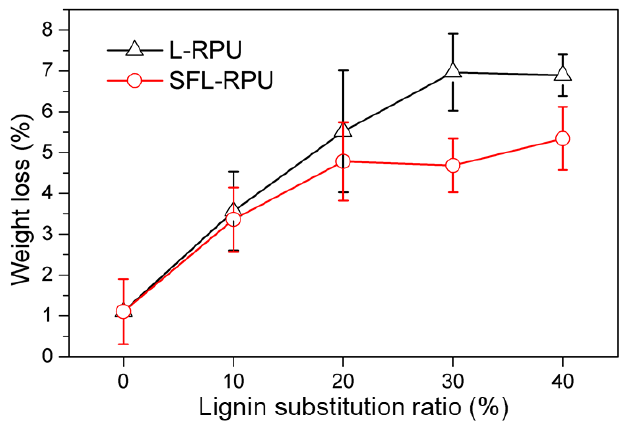
Figure 4. Weight loss of PU0, SFL-RPU and L-RPU foams after